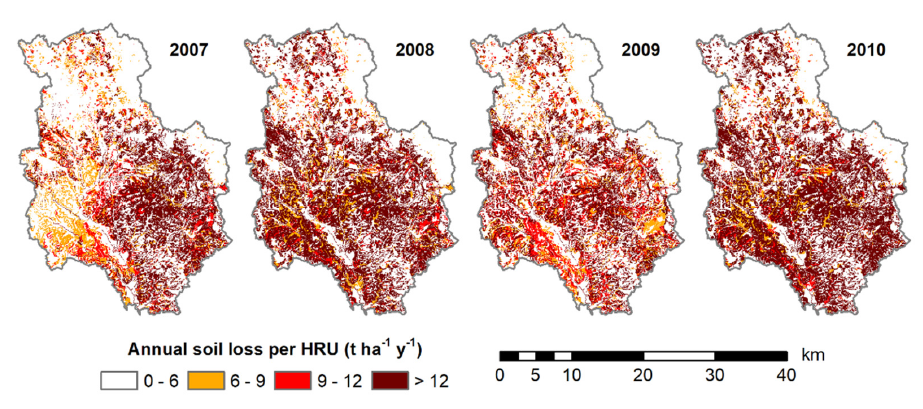
Figure 6. Spatial comparison of estimated soil losses in the period 2007–2010.